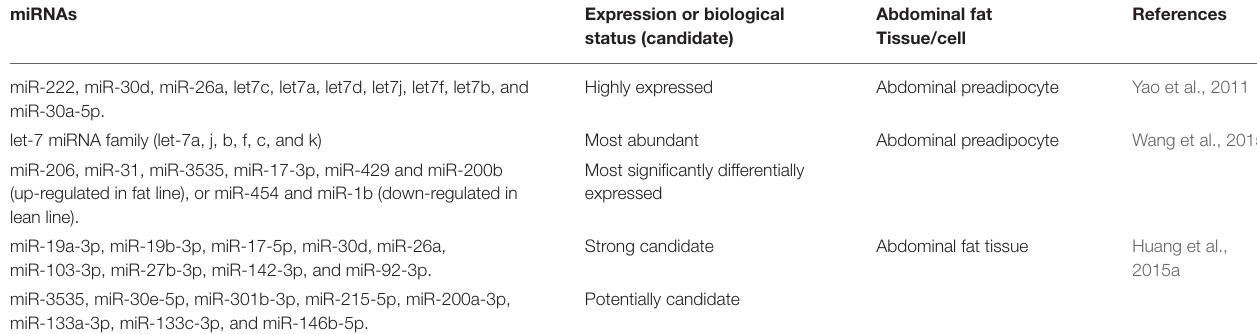
TABLE 3 | Several miRNAs found to be highly involved in the regulation of chicken abdominal fat deposition or fat cell accumulation identified by deep sequencing.